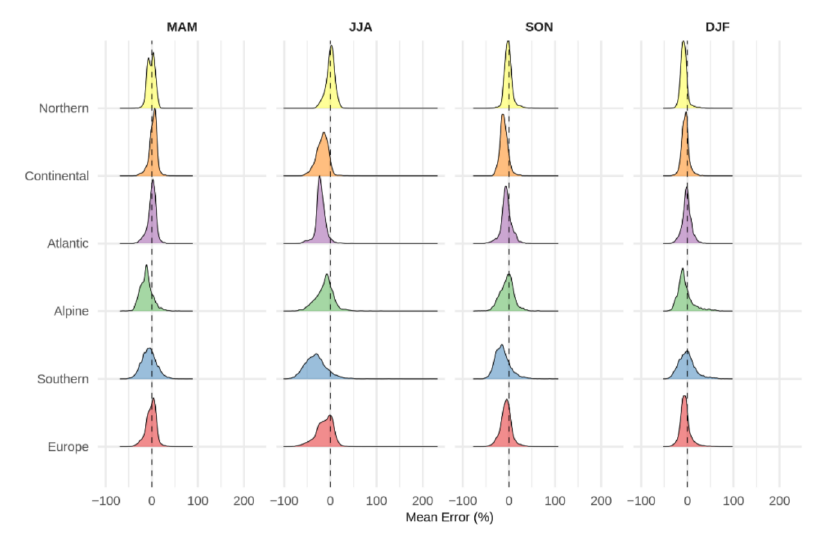
Figure 5. Relative ME distributions of unadjusted ECMWF SEAS5 ensemble seasonal forecasts of precipitation (one-month lead time) for European sub-regions and over the whole domain. ME was computed with respect to ERA5 over 1993–2016.